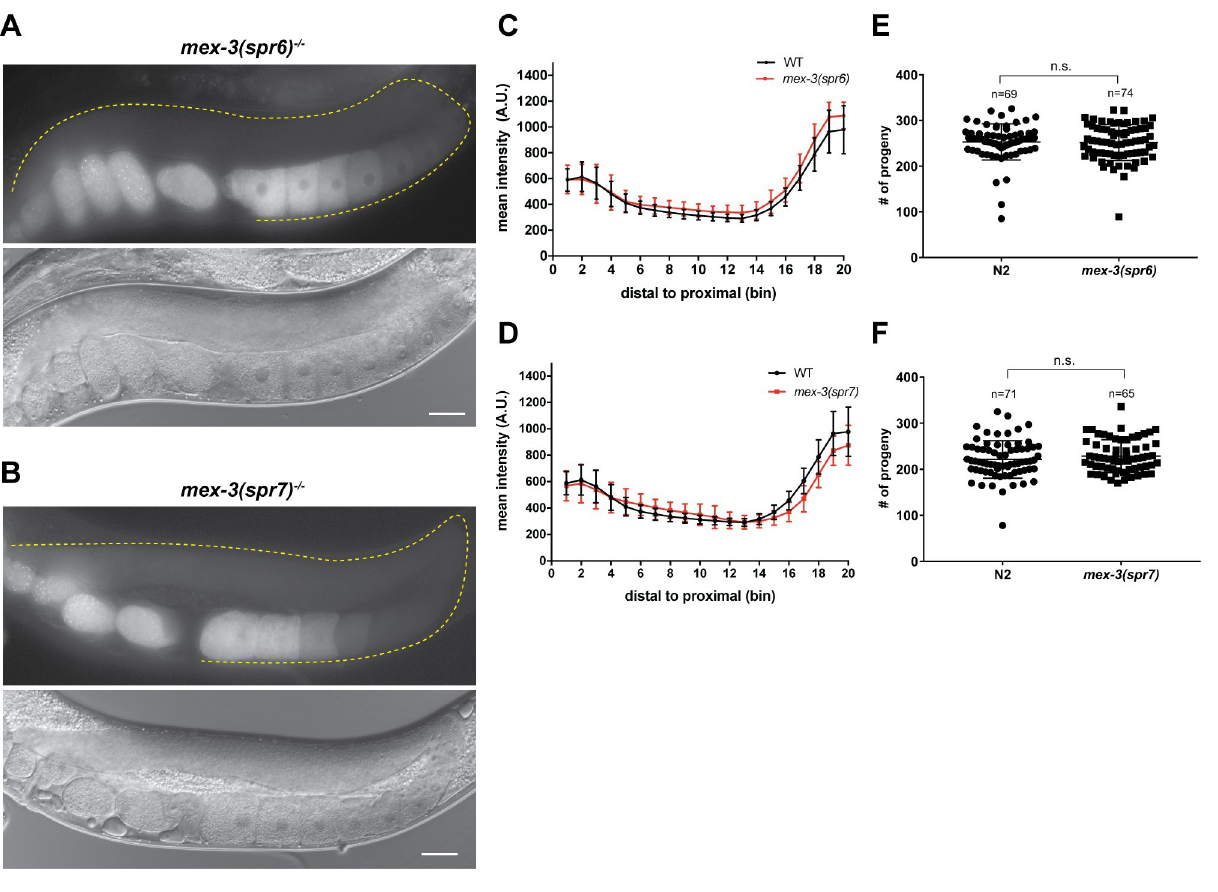
Fig 3. Deletion of the 26-167bp or 515-648bp regions of the mex-3 3´UTR does not alter MEX-3 expression pattern or affect fertility. (A) DIC and fluorescence images of the homozygous mex-3(spr6) mutant animals. (B) DIC and fluorescence images of the homozygous mex-3(spr7) mutant animals. (C) quantitative analysis of the fluorescence intensity in the homozygous mex-3(spr6) mutant animals compared to that of wild type GFP::MEX-3 (n = 16). (D) quantitative analysis of fluorescence intensity in the homozygous mex-3(spr7) mutant animals compared to that of wild type GFP::MEX-3 (n = 21). (E) brood size assay of homozygous mex-3(spr6) mutant animals at 20˚C.There is no reduction in the brood size. (F) brood size assay of homozygous mex-3 (spr7) mutant animals at 20˚C. Each dot in panels E and F represents the brood size of an individual animal. In each panel, data from three biological replicates are shown in the graph. All p-values for panels C and D are reported in S4 Table. P-values in panels E and F are from a Kolmogorov-Smirnov test. All images taken at 40x magnification. Scale bar = 30 μ